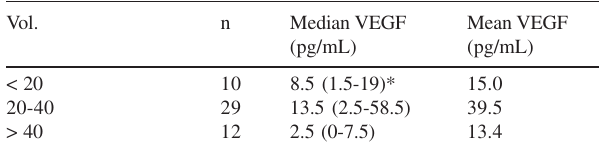
Table 2 - Relationship between plasma vascular endothelial growth factor (VEGF) and Gleason score Gleason score